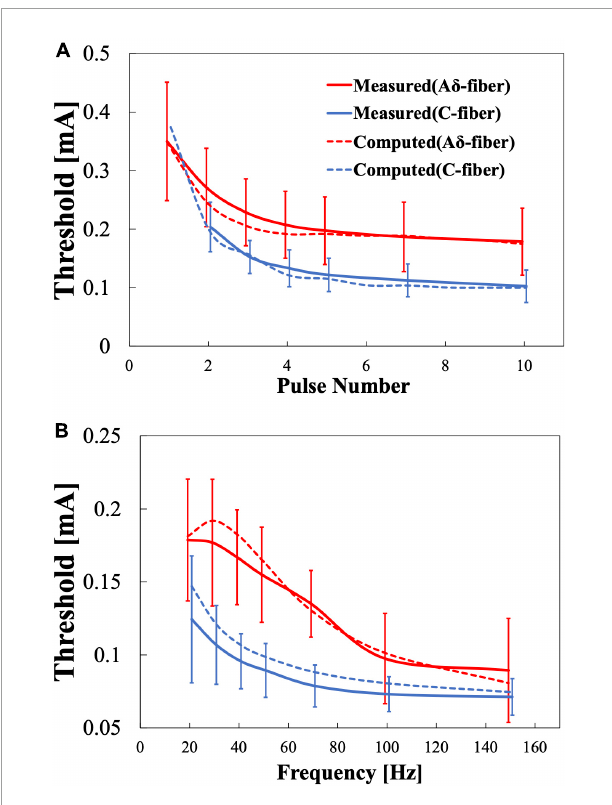
FIGURE6 Multiscale electrical stimulation model results for pain thresholds. (A) Variation with the number of stimulation pulses when the frequency is fixed at 30 Hz. (B) Variation with frequency when the stimulation pulse number is fixed at 4.